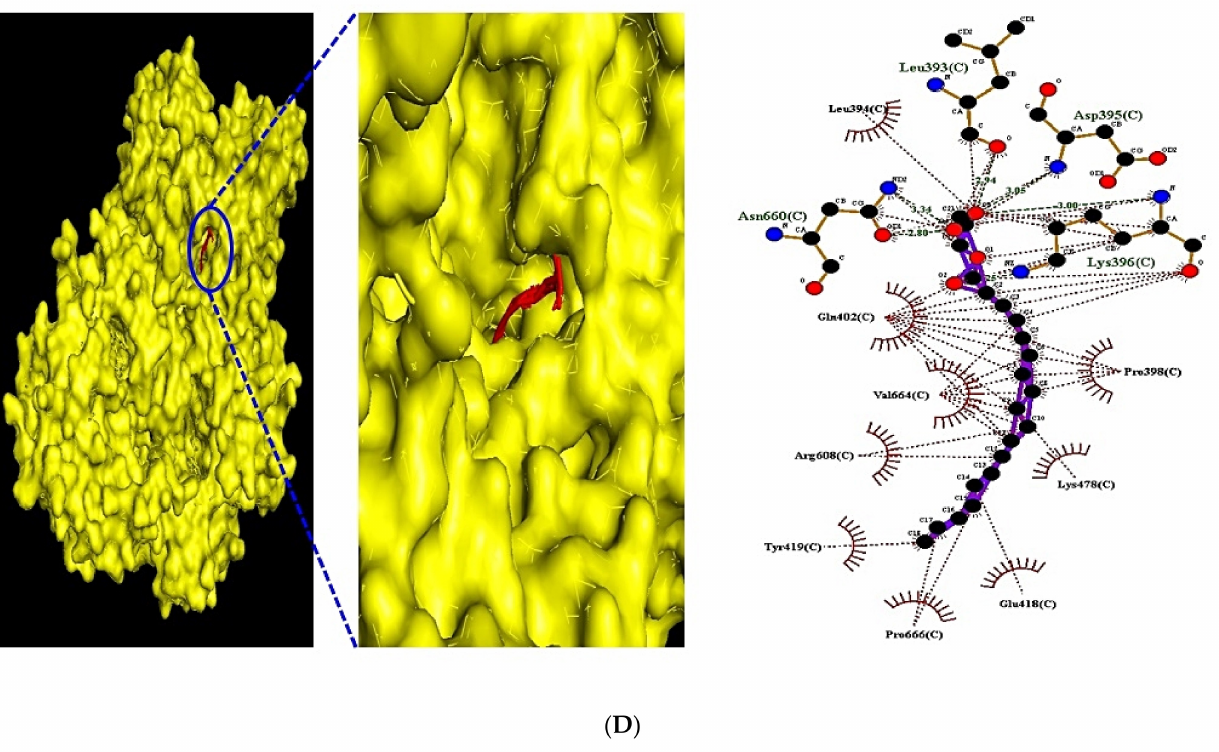
Figure 8. ( A ) MDT of campesterol (PubChem ID: 173183) on FGF1 (PDB ID: 3OJ2). ( B ) MDT of 26,27-Dinorergosta-5,23-dien- 3 β -ol (PubChem ID: 22213488) on FGF2 (PDB ID: 1IIL). ( C ) MDT of CBMicro_013618 (PubChem ID: 1109374) on TNFRSF1A (PDB ID: 1NCF). ( D ) MDT of monoolein (PubChem ID: 5283468) on PRKCA (PDB ID: